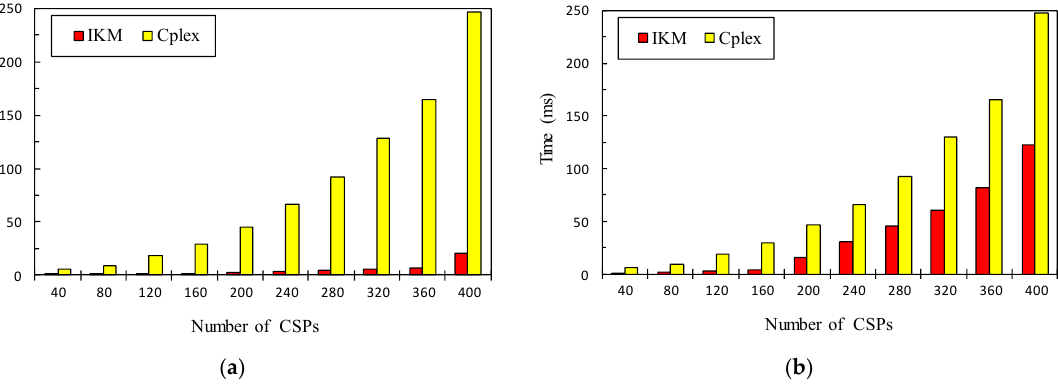
Figure 12. Average time consumption vs. number of CSPs (Sets #2.1 and #2.2). ( a ) Set #2.1; ( b ) Set #2.2.